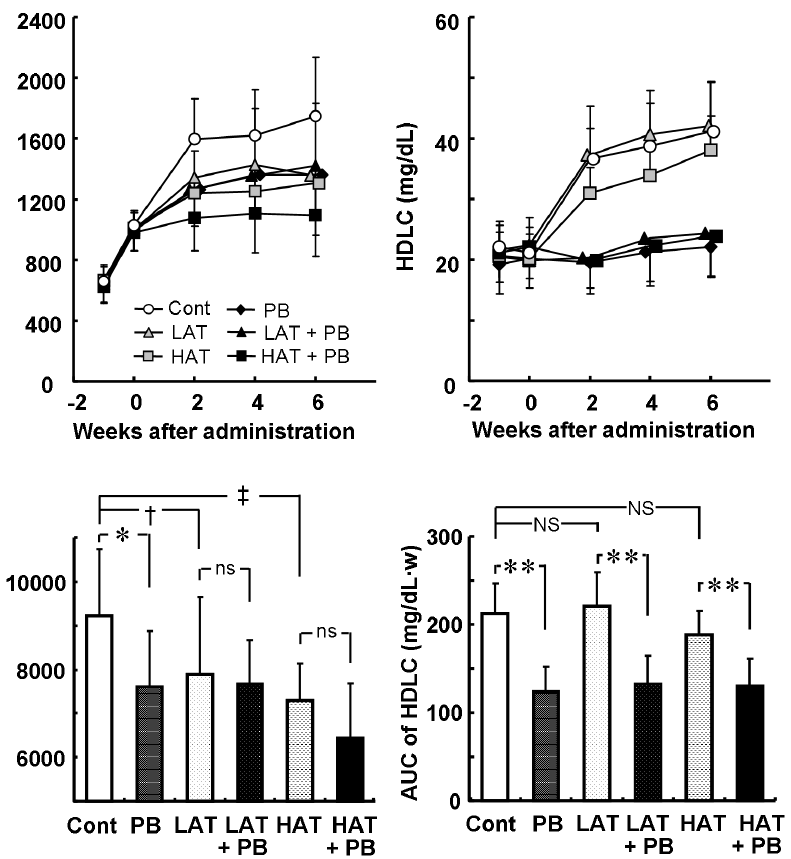
Figure 1. Effects of probucol and atorvastatin on plasma cholesterols. Time-dependent changes in plasma cholesterols (A) and their AUC values over the 6-week period of administration (B). Data are presented as mean 6 SD. There were 11 animals in the control (Cont), 0.1% probucol (PB), 0.001% atorvastatin (LAT), LAT + PB groups, and 12 in the 0.003% arorvastatin (HAT) and HAT + PB groups. *p , 0.05; **p , 0.01; ns, not significant by unpaired t-test. { p , 0.05; ` p , 0.01 by Williams test (Regression analysis; linearity, p , 0.01; LOF, not significant). NS, not significant by Dunnett’s test.